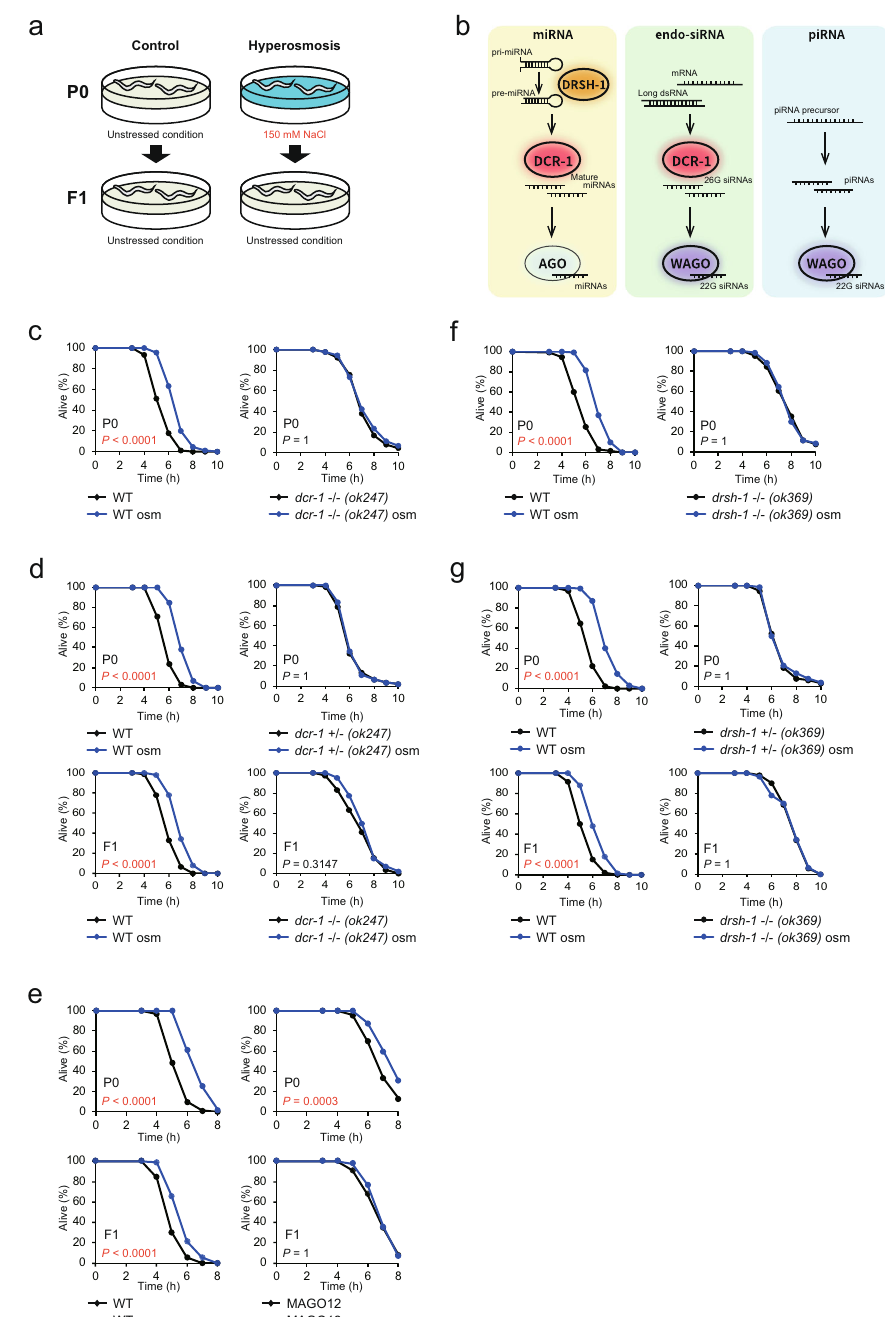
Fig. 1 MiRNAs and endo-siRNAs differentially mediate the acquisition and inheritance of hormesis. a Scheme for exposure to the environmental stress condition. The P0 parents were exposed to hyperosmosis during developmental stages and the F1 descendants were raised under unstressed conditions. b Overview of small RNA pathways in C. elegans . c Oxidative stress resistance (2.0 mM H 2 O 2 ) of wild-type (WT) N2 worms (left) and dcr-1 homozygotes (right) in the P0 generation. d Oxidative stress resistance of WT (upper left) and dcr-1 heterozygotes (upper right) in the P0 generation and WT (lower left) and dcr-1 homozygotes (lower right) in the F1 generation. e Oxidative stress resistance (1.8 mM H 2 O 2 ) of WT (left) and MAGO12 mutants (right) in the P0 generation (upper) and the F1 generation (lower). f Oxidative stress resistance (2.0 mM H 2 O 2 ) of WT (left) and drsh-1 homozygotes (right) in the P0 generation. g Oxidative stress resistance of WT (upper left) and drsh-1 heterozygotes (upper right) in the P0 generation and WT (lower left) and dcr-1 homozygotes (lower right) in the F1 generation. Homozygotes of dcr-1 or drsh-1 were distinguished from heterozygotes by GFP expression. Three independent experiments are integrated into each survival curve ( n = 90). Mean survival time and statistics are presented in Supplementary Data 1. P values were calculated by log-rank test with Bonferroni